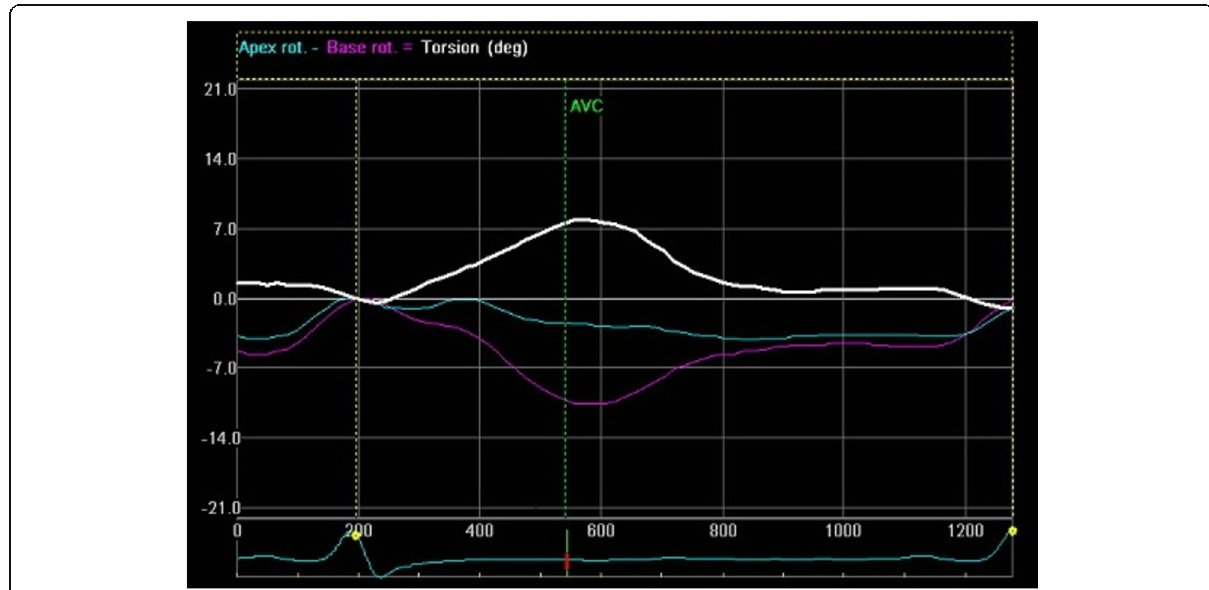
Fig. 1 Speckle tracking echocardiography (Echo Pac software) in patients with LVNC showing net basal rotation (purple color) and net apical rotation (green color) in the same counter-clockwise direction. Net torsion is displayed in white color